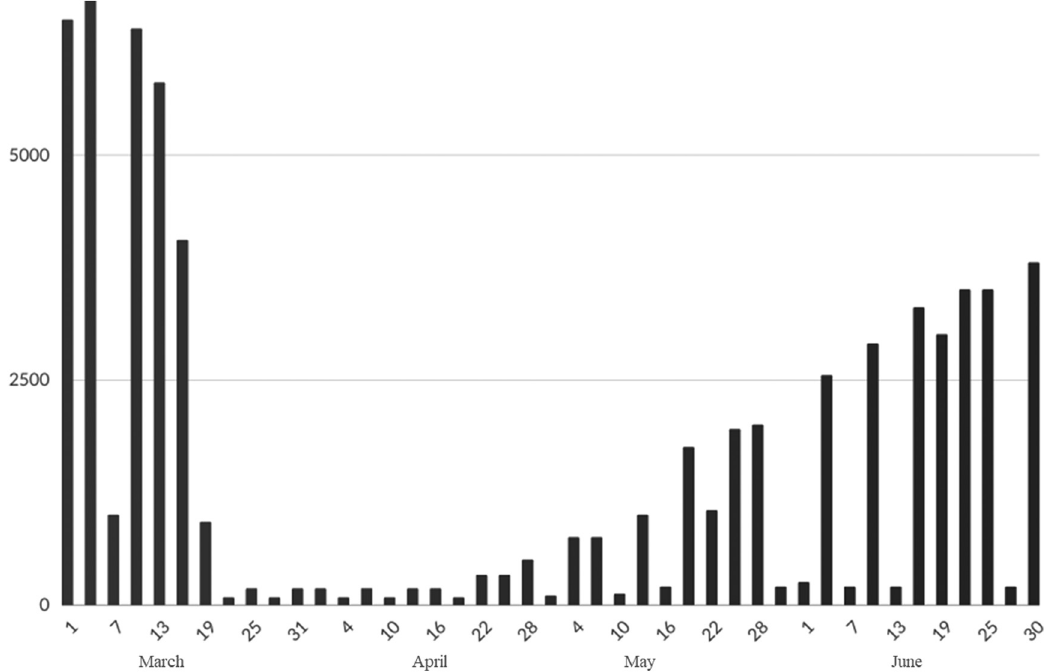
Figure 4: Number of CERN users at the site from March to June 2020 by CERN SUSI ( SUrveillance des SItes )